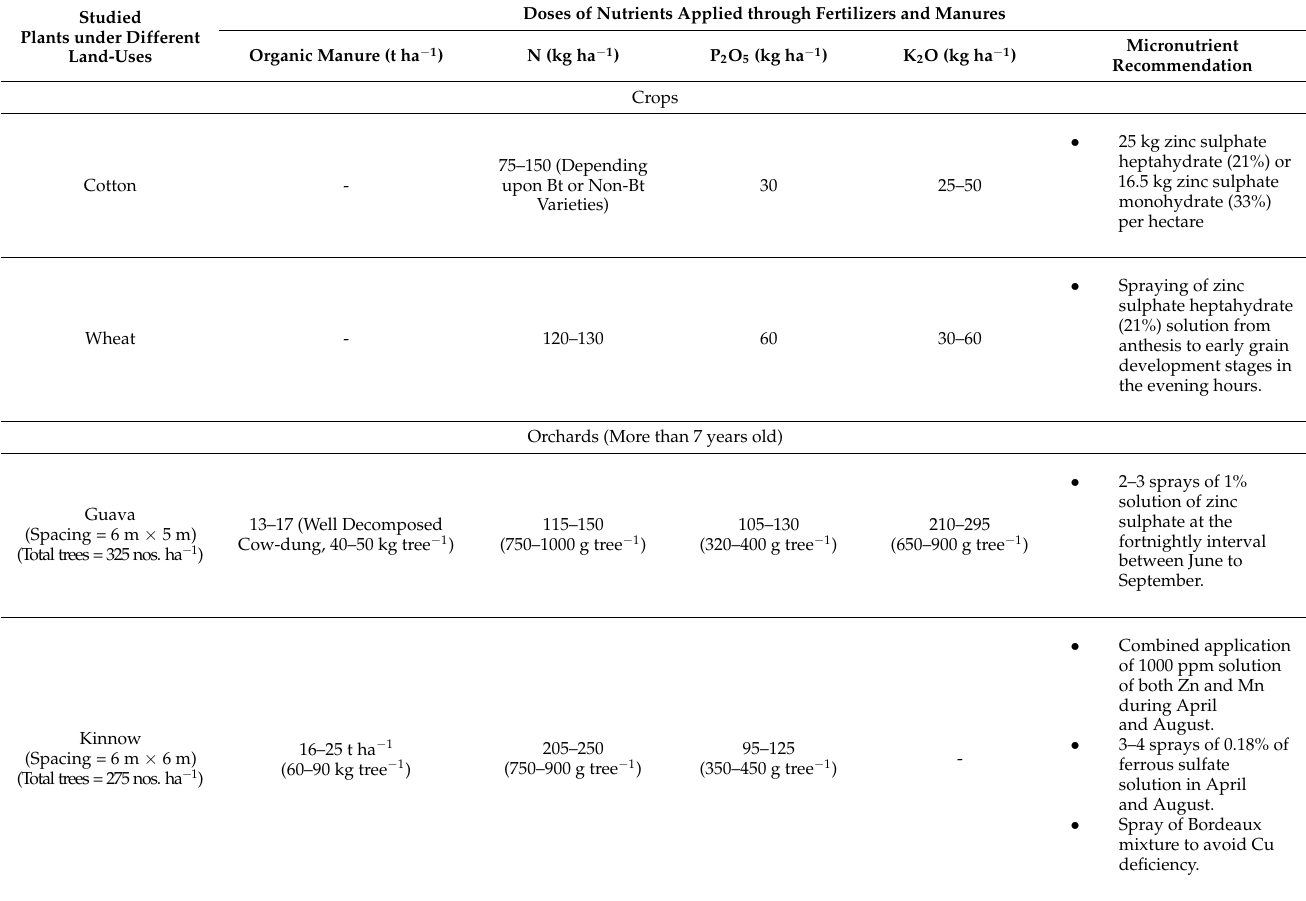
Table 2. Fertilization and manuring practiced in the studied land